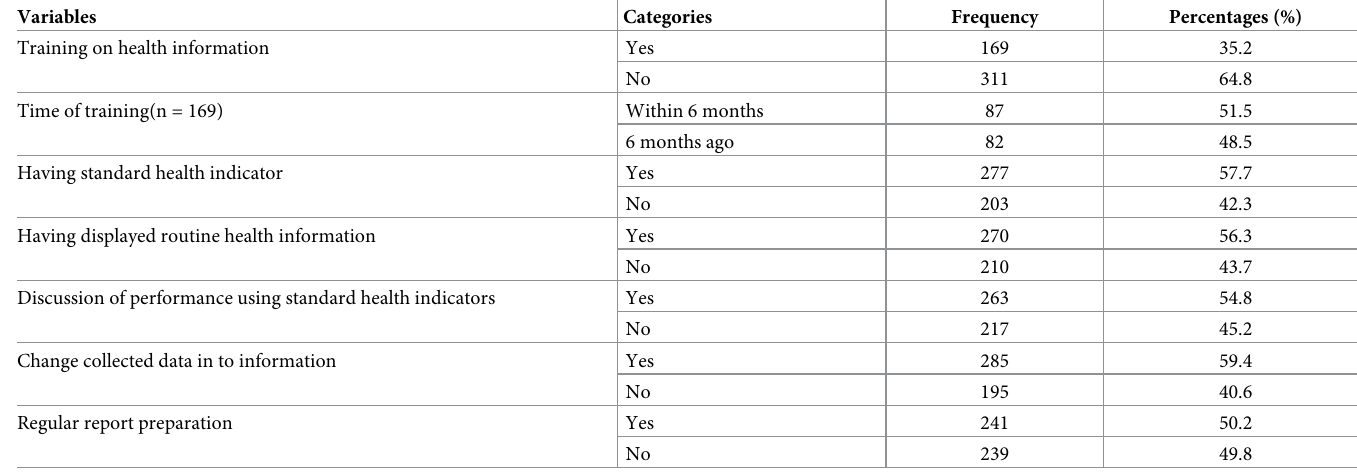
Table 2. Technical characteristics of health workers working at public health facilities of Hadiya zone, SNNRP, Ethiopia, 2019, (n = 480).